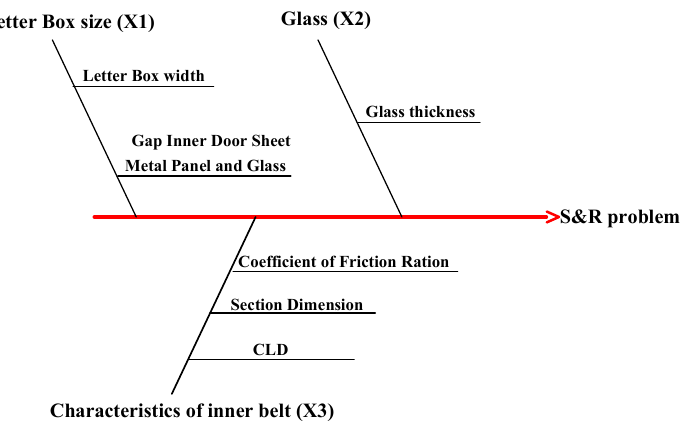
Figure 10. Fishbone diagram of related factors in transverse X. The factors affecting X1, X2 and X3 are listed on the fishbone.